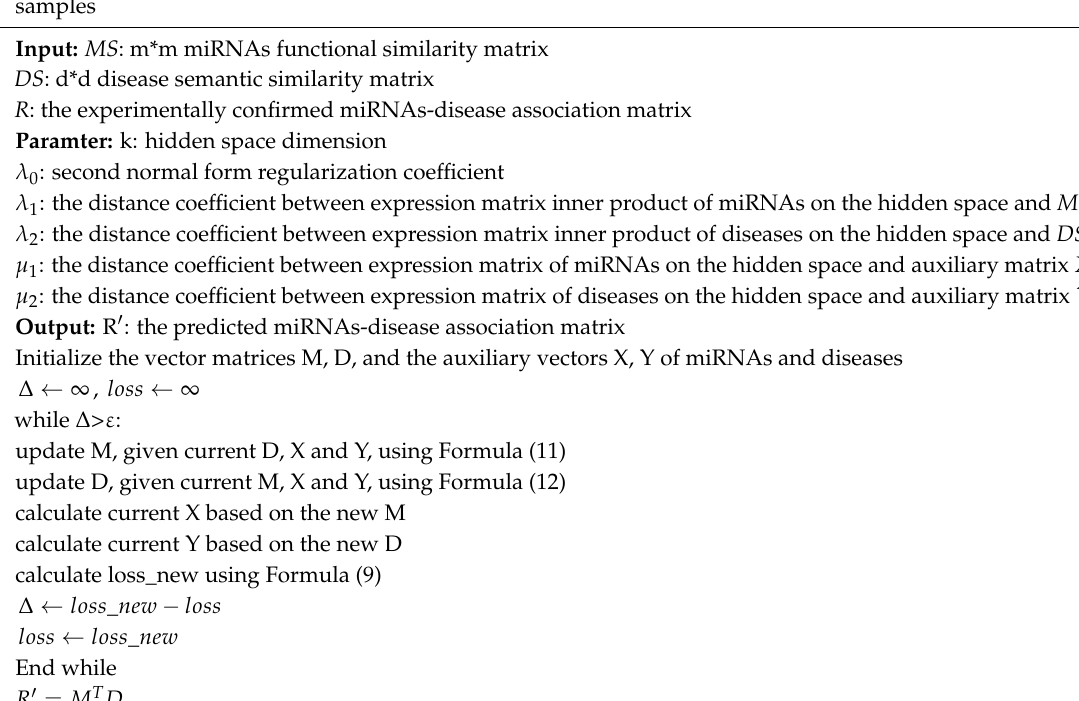
Algorithm 1: LFEMDA, predicting miRNA-disease association by latent feature extraction with positive